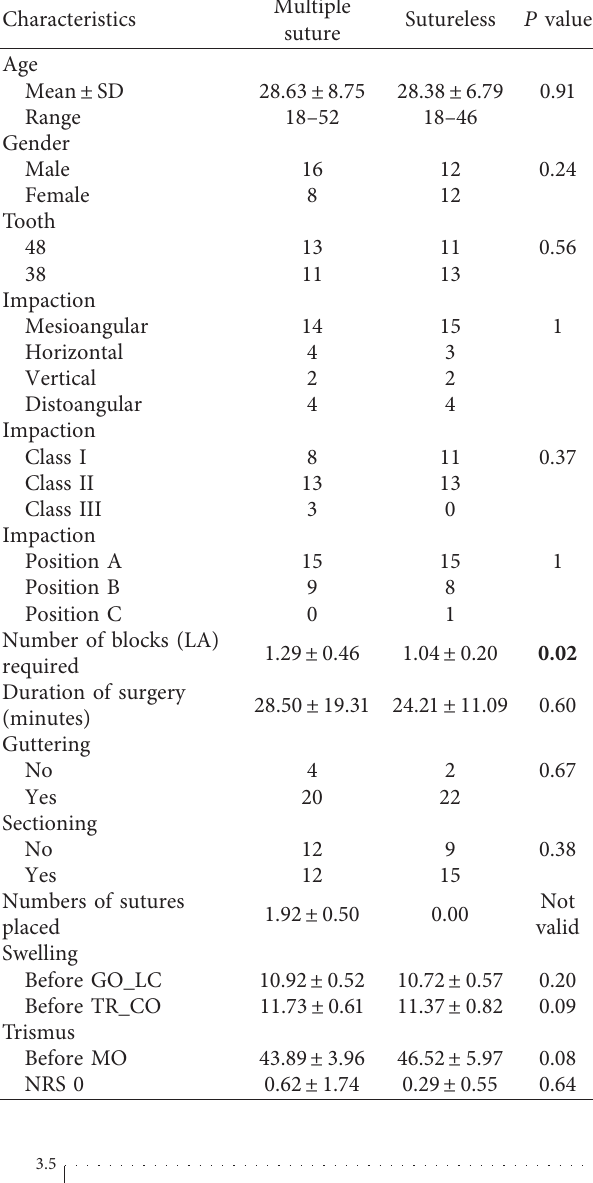
Table 1: Demographic, anatomic, operative, and baseline patient